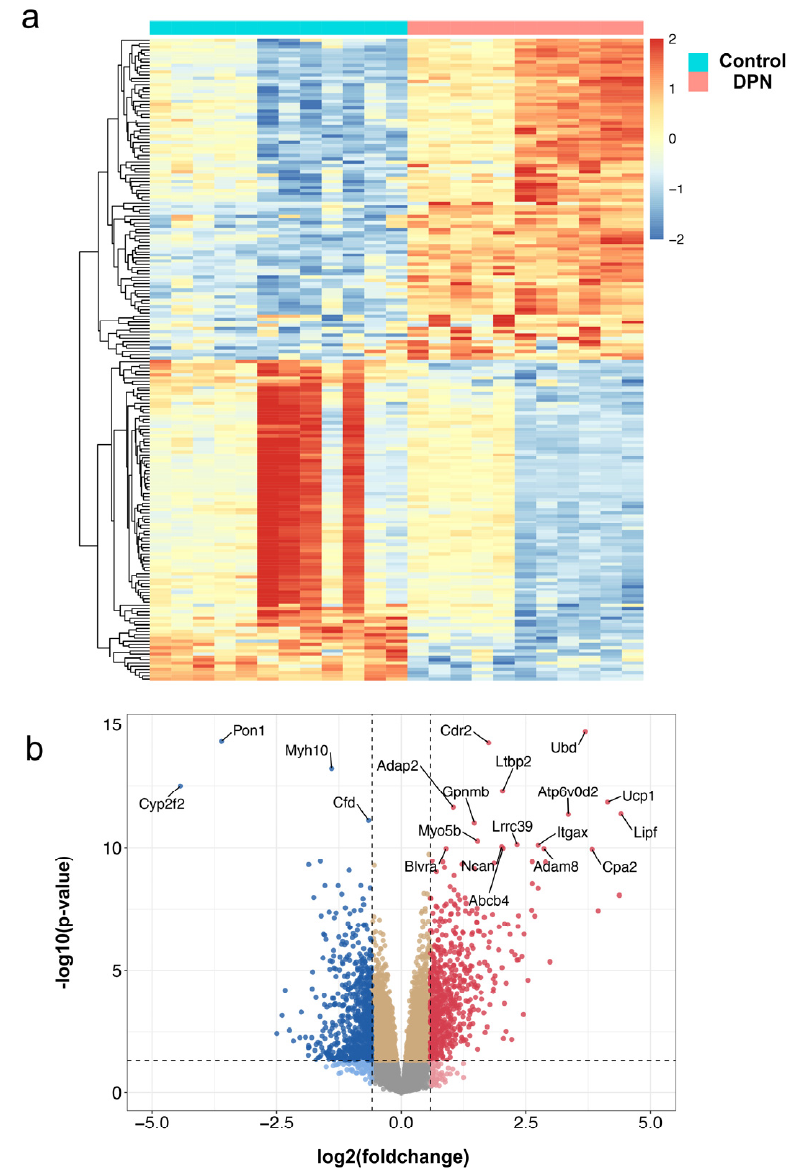
Figure 2. Identification of DEGs. ( a ) The heatmap of the DEGs derived from integrated analysis. The red and blue colors represent upregulated DEGs and downregulated DEGs, respectively. ( b ) The volcano plot of normalized microarray data. The upregulated and downregulated genes are marked in red and blue, respectively.